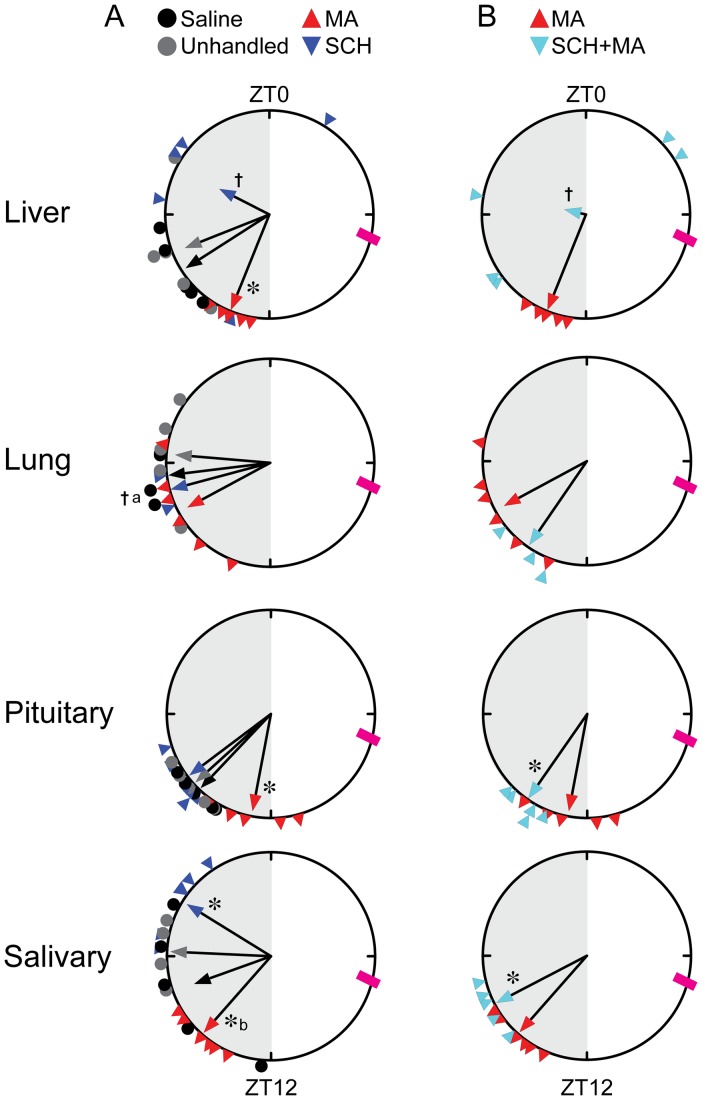
MA and SCH injections affect the phase of PER2::LUC expression in circadian oscillators.Rayleigh plots of the phases of peak PER2::LUC expression in liver, lung, pituitary gland, and salivary gland. Rayleigh plots can be read as a 24h clock, with ZT0 at the top and ZT12 at the bottom of the circle. Arrows represent the average peak phase of PER2::LUC expression (mean vectors for the circular distributions) of each group. The length of the vector represents the strength of the phase clustering while the angle of the vector represents the mean phase. Individual data points are plotted outside the circle. The pink box at ZT7 indicates the timing of MA injection for MA-treated groups. A) Data from groups that were saline-injected, unhandled, injected with MA (MA), or injected with SCH23390 alone (SCH). MA resulted in a significant phase advance in liver and pituitary gland (*, p<0.05 compared to saline, unhandled, and SCH groups). In salivary gland, MA advanced phase relative to unhandled controls (*b, p<0.05) whereas SCH significantly delayed phase compared to all other groups (saline, unhandled, or MA-injected). SCH administration resulted in desynchrony among livers (†, Rayleigh p>0.10). SCH administration also resulted in arrhythmicity in 4/6 lungs. Lungs from SCH-treated animals also failed to demonstrate significant synchrony (†a, Rayleigh p>0.10), although this was probably the result of decreased statistical power due to the low number of remaining rhythmic cultures. B) Data from groups that were pretreated with SCH before MA injection (SCH+MA) or injected with MA alone (same data as A). SCH pretreatment significantly attenuated the MA-induced phase shift in pituitary and salivary gland (*, p<0.05) and disrupted synchrony among livers (†, Rayleigh p>0.10). SCH+MA also resulted in arrhythmicity in 2/5 lungs.